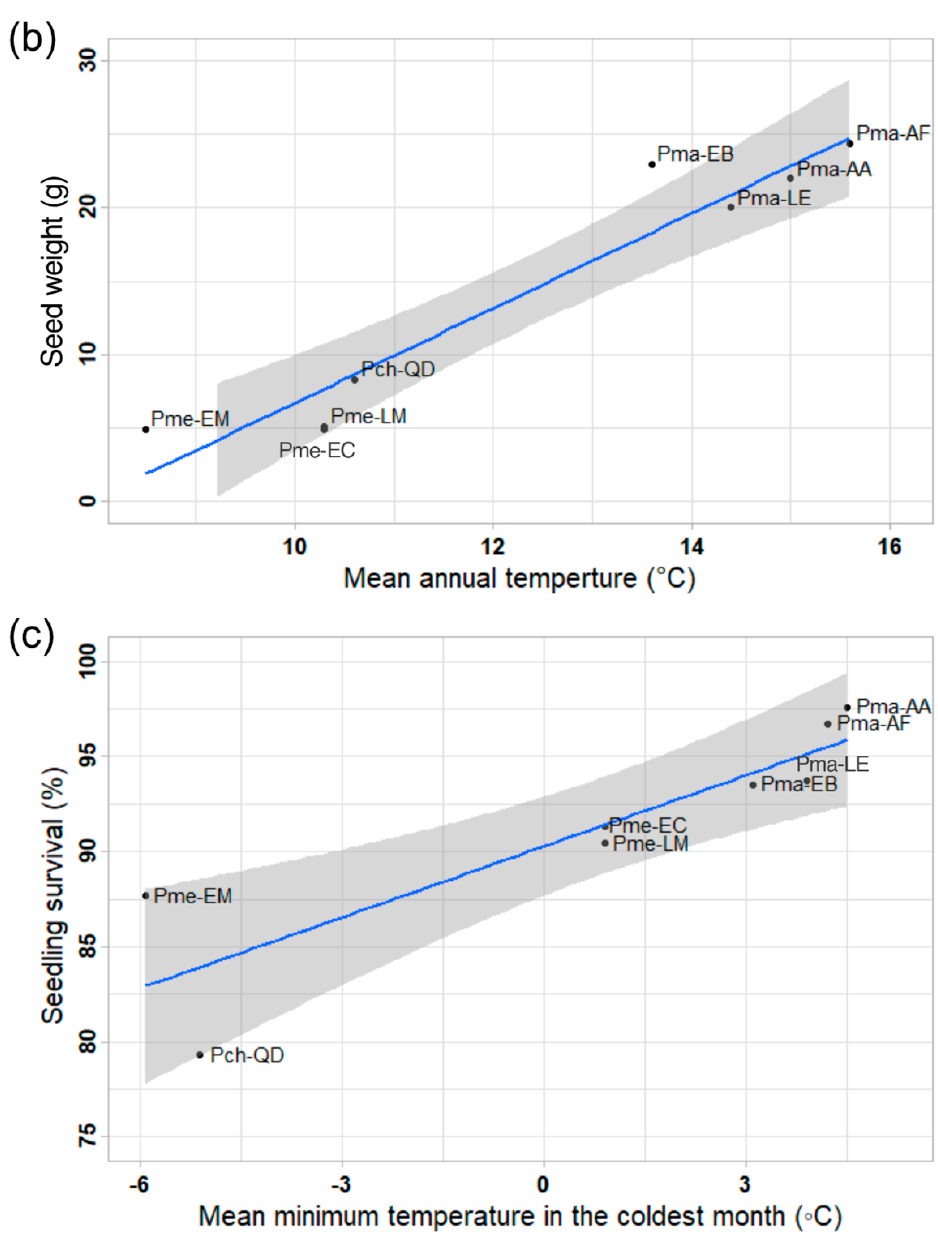
Figure 4. Linear regression models of ( a ) seedling height with percentage of organic matter ( R 2 adj = 0.77, p value = 0.0026, slope parameter ( β ) = 2.24, intercept = 58.54); ( b ) seed weight with mean annual temperature ( R 2 adj = 0.90, p value = 0.0002, slope parameter ( β ) = 3.23, intercept= − 25.68); and ( c ) seedling survival with mean minimum temperature of the coldest month ( ◦ C) ( R 2 adj = 0.75, p value = 0.0035, slope parameter ( β ) = 1.25, intercept = 90.27) of seed origin; blue lines = mean values and grey area = 95% confidence level intervals for